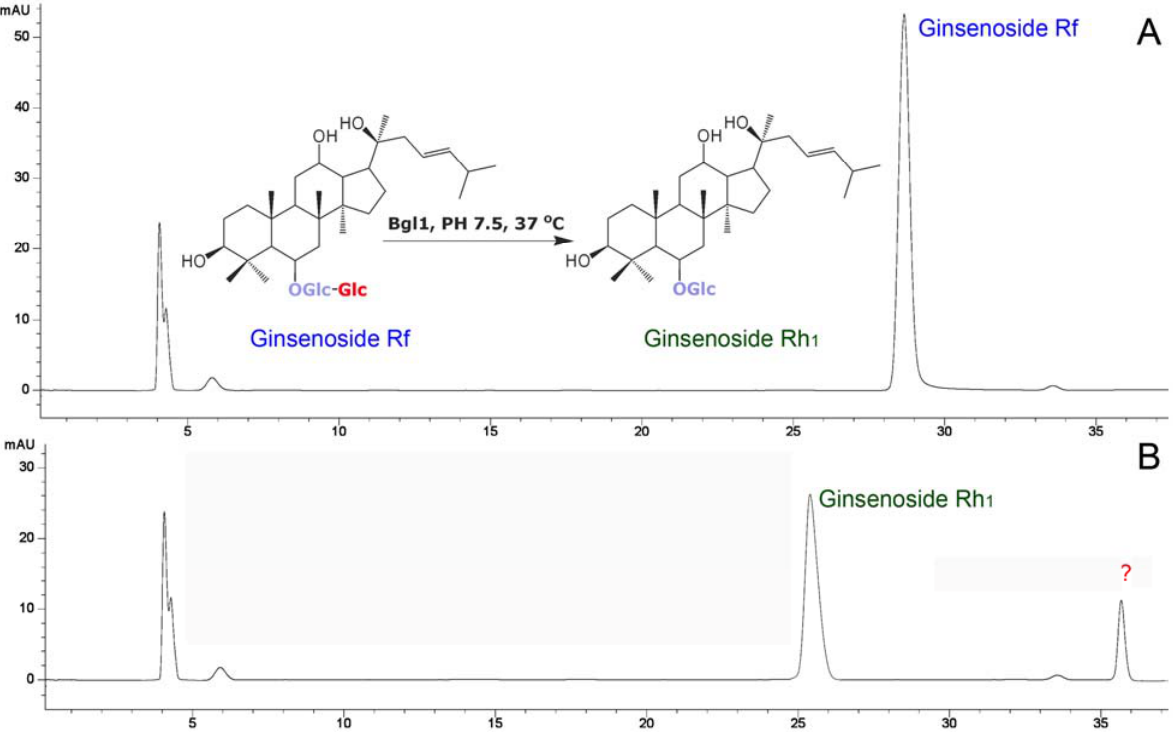
Figure 3. HPLC trace of enzyme assay. A: Trace of substrate ginsenoside Rf; B: Trace of enzyme assay of ginsenoside Rf reacted with